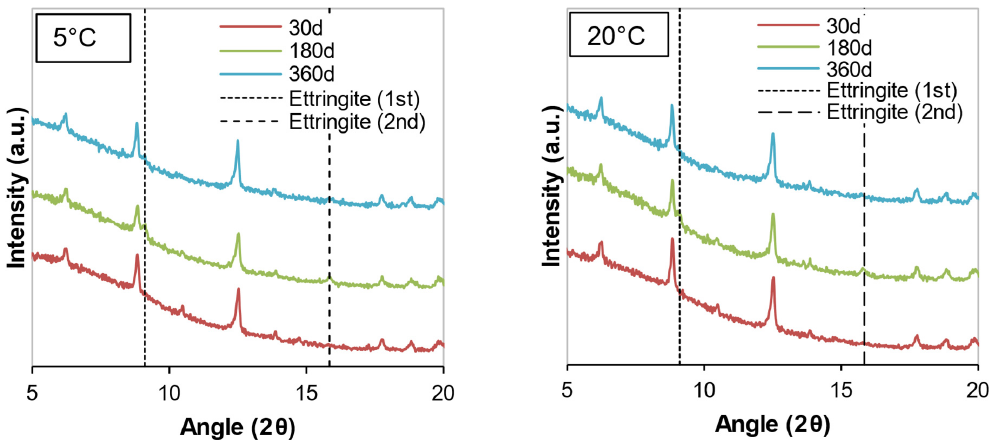
Figure 14. Diffractograms of S + C + W3 at different temperatures.